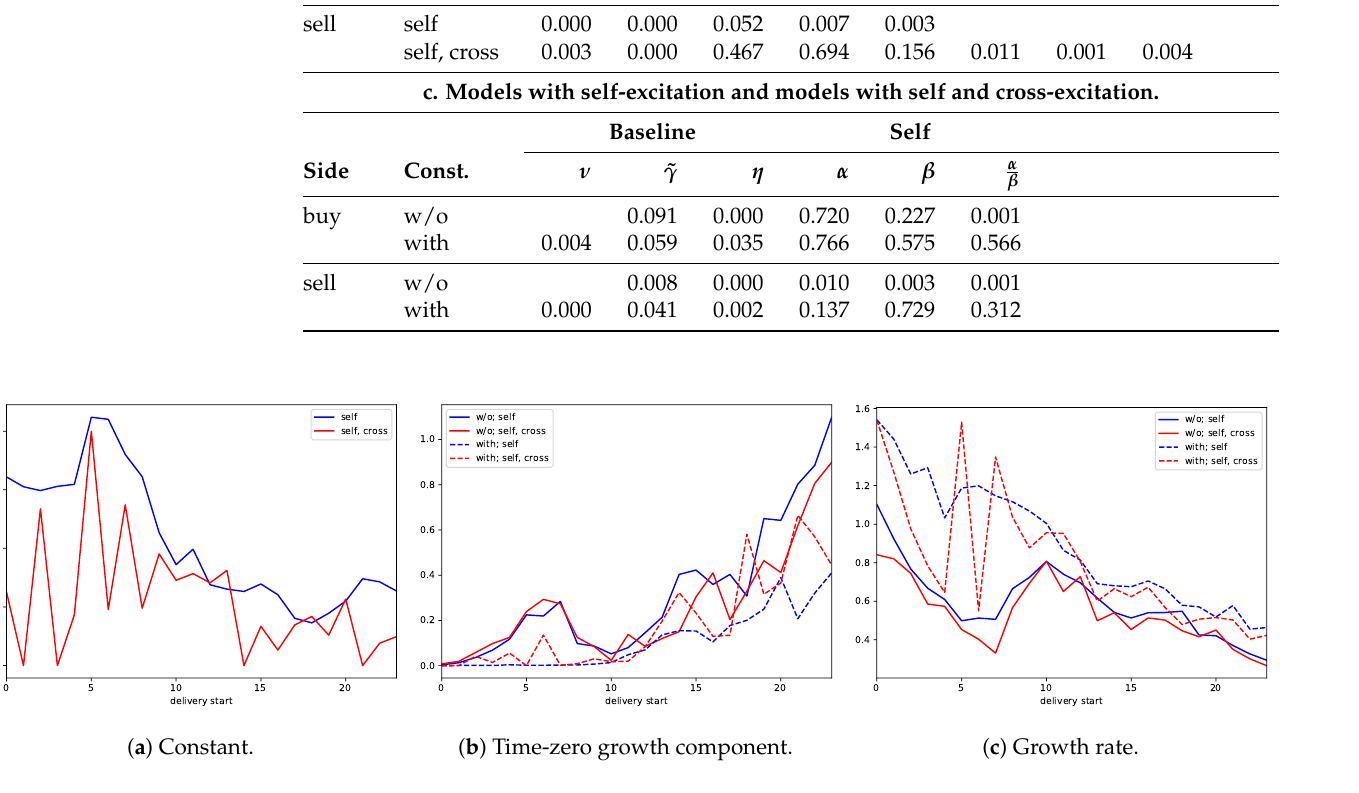
Figure 4. Median baseline intensity parameters conditional on the hour of delivery